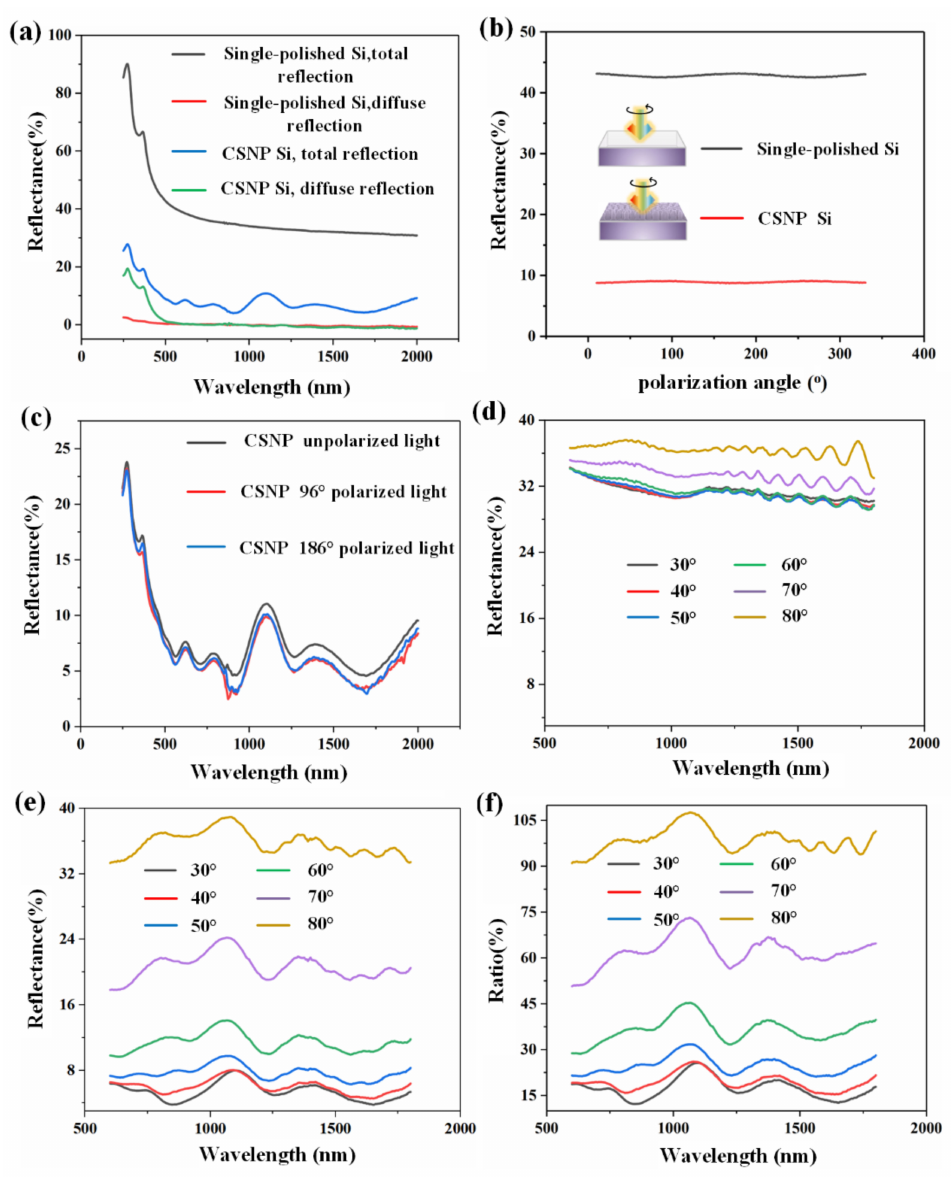
Figure 4. Reflectance measurement curves: ( a ) the curve of transmittance versus wavelength for the total reflection and diffuse reflection of single-polished Si and CSNP Si. ( b ) polarization-dependent measurements of the total reflection for single-polished Si and CSNP Si, with a fixed incident light wavelength of 500 nm, inserts illuminate the corresponding samples ( c ) wavelength-dependent total reflection measurements of the CSNP Si. ( d ) wavelength dependent total reflection measurements of the single-polished Si, with incident angles between 30 ◦ –80 ◦ . ( e ) wavelength dependent total reflection measurements of the CSNP Si, with incident angles between 30 ◦ –80 ◦ . ( f ) reflectance ratio calculated by using data from ( e ) divided by that of ( d ). ( a – c ) are the normal incidence measurements with a standard 8 ◦ incident